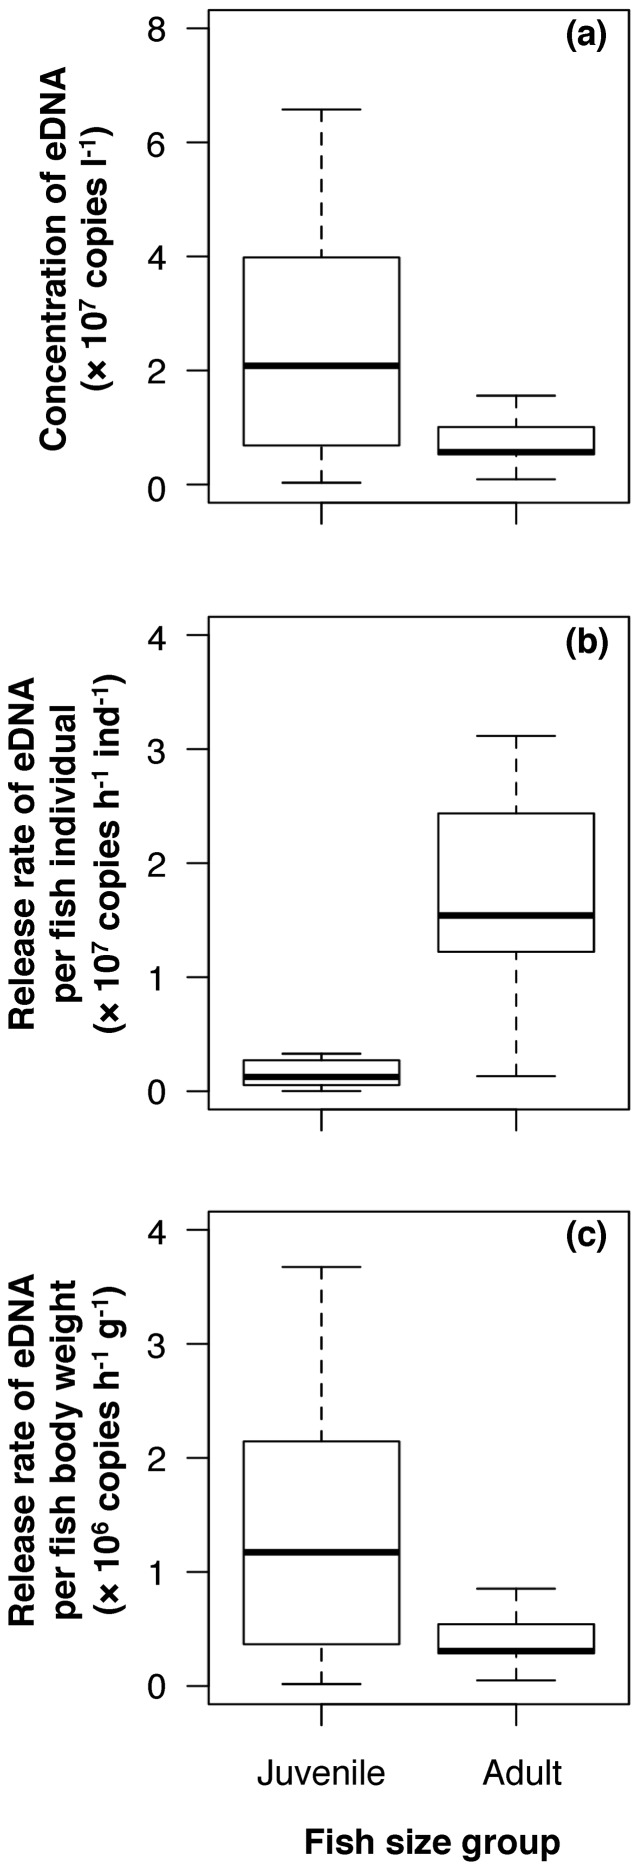
Box plots of the eDNA release compared between juvenile and adult groups.a) Stabilized concentration, b) release rate per individual fish, and c) per fish body weight. Body wet weight was 0.5–2.0 g (n = 10) and 30–75 g (n = 9), respectively.